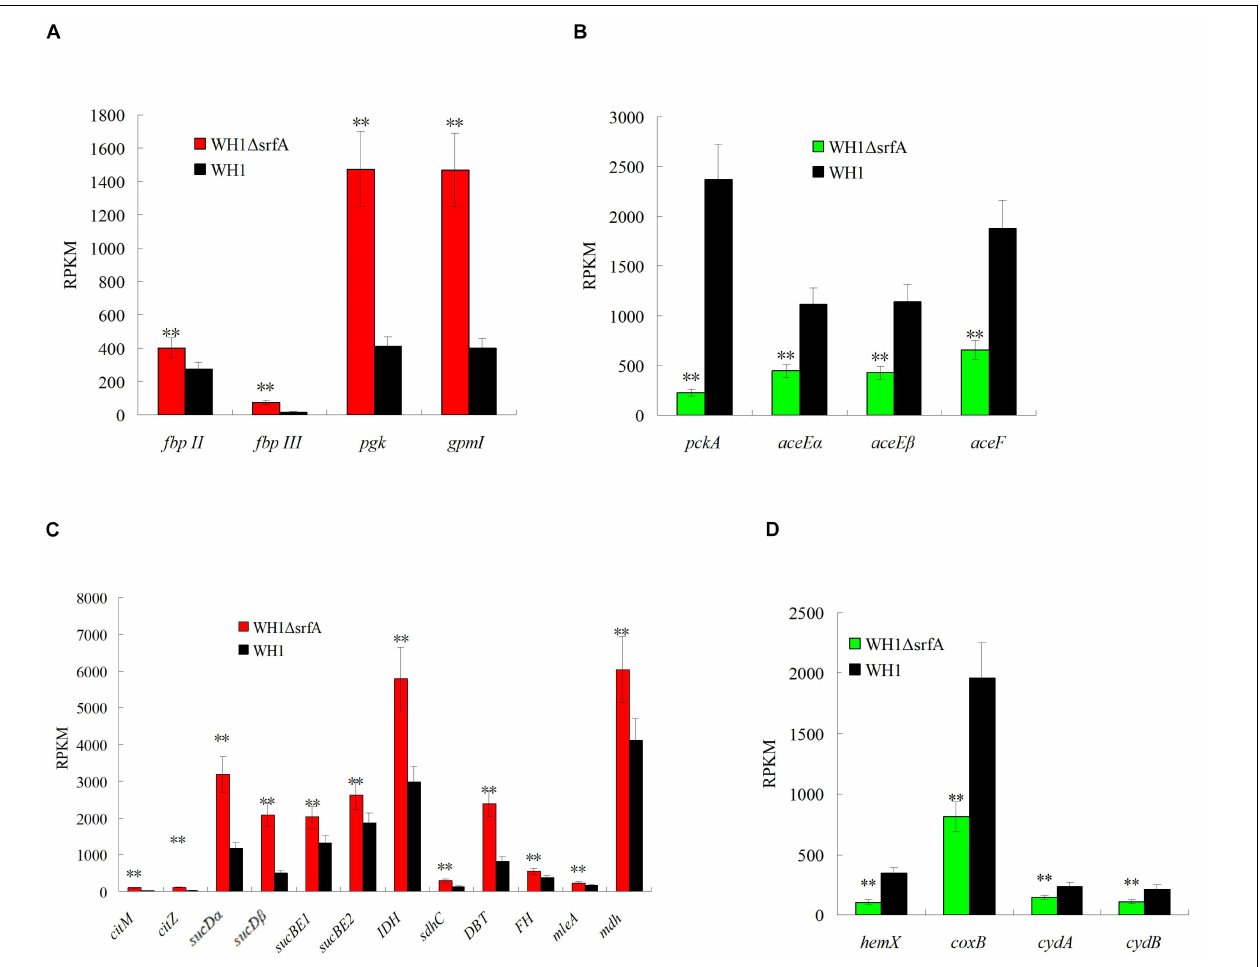
FIGURE 2 | Comparison of the gene transcription involved in EMP, pyruvate dehydrogenation, TCA, and oxidative phosphorylation between (cid:49) srfA and WH1. (A) EMP. (B) Pyruvate dehydrogenation. (C) TCA. (D) Oxidative phosphorylation. Data were analyzed on the basis of transcriptomes. Double stars indicate significant difference ( p < 0.01) between (cid:49) srfA and